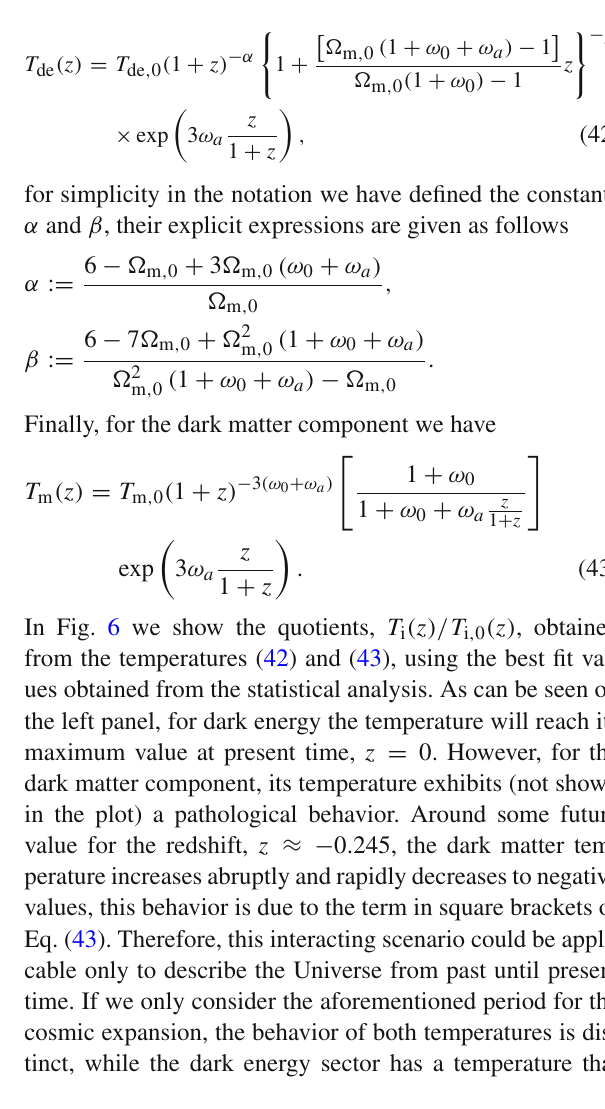
Fig. 5 Q -term. The black solid line corresponds to the best fit values for the parameters of the model and the shaded region corresponds to the errors